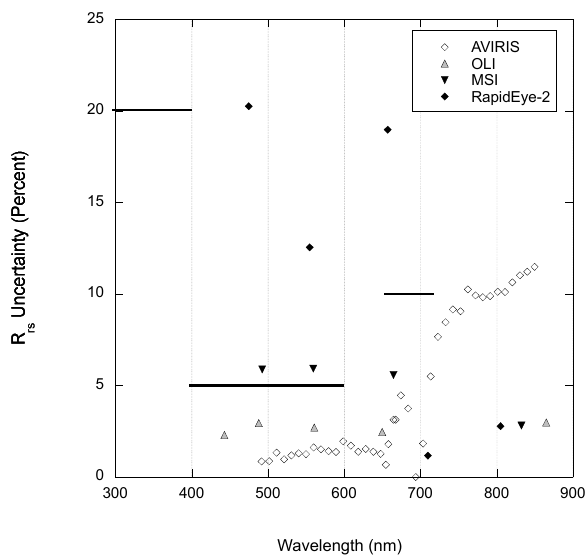
Figure 7. Percent R rs uncertainty for a kelp target at Coal Oil Point. Solid horizontal lines indicate the recommended percent uncertainty from the Plankton Aerosol, Cloud and ocean Ecosystem (PACE) Science Definition Team. Data below ~490 nm for AVIRIS were removed because of negative radiances after atmospheric correction.